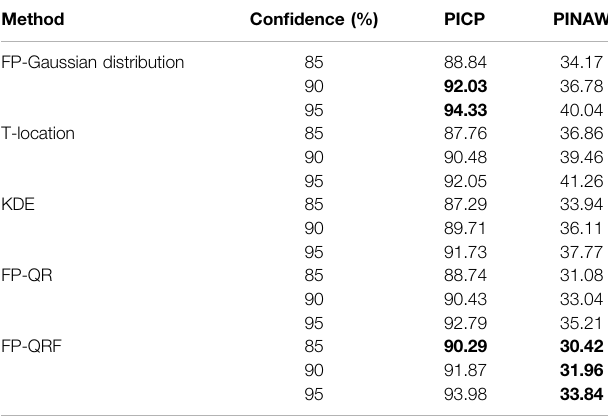
TABLE 2 | Interval prediction indicators with different con fi dence levels for each method. Method Con fi dence (%) PICP PINAW FP-Gaussian distribution